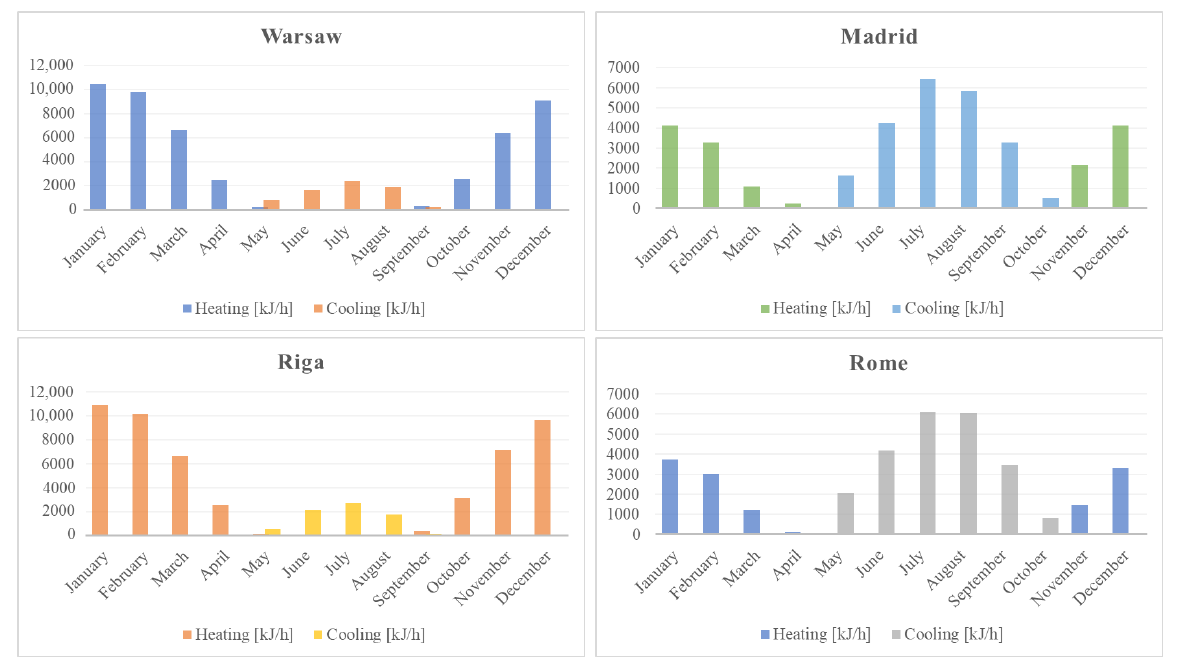
Figure 4. Results of heating and cooling mean load calculations. After summarizing heating and cooling loads in different months, energy demand was calculated (Figure 5).